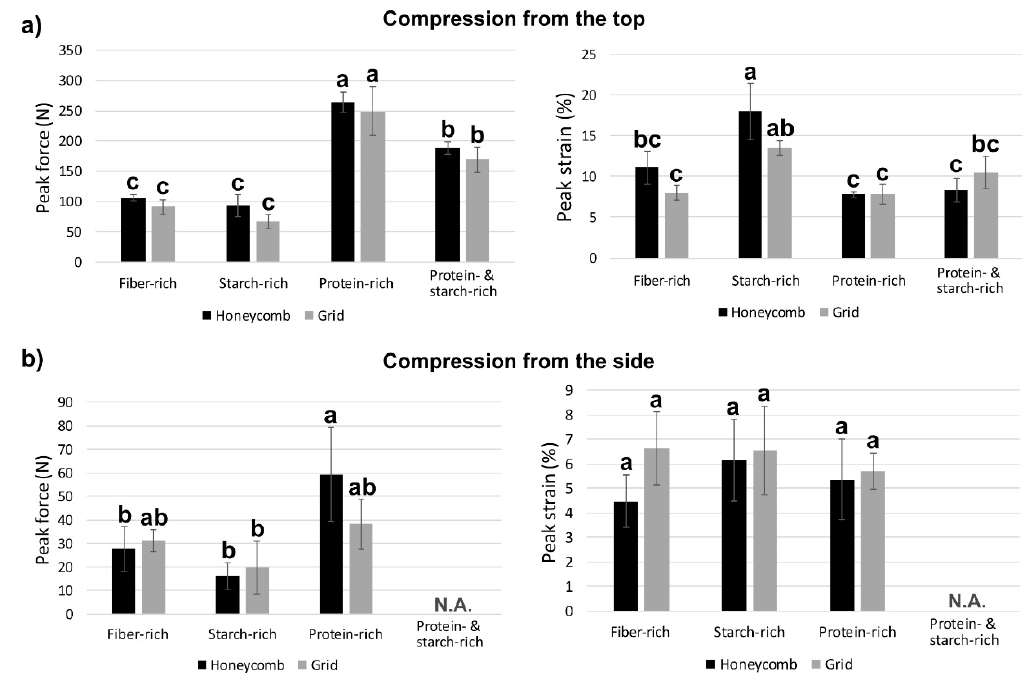
Figure 2. Peak force and corresponding strain (peak strain) from compression tests on 3D-printed samples ( a ) compressed from above with the infill pattern facing upwards and ( b ) compressed from above with the infill pattern facing sideways. Different letters (a, b, c) within panels indicate significant differences ( p < 0.05). N.A.—not applicable.